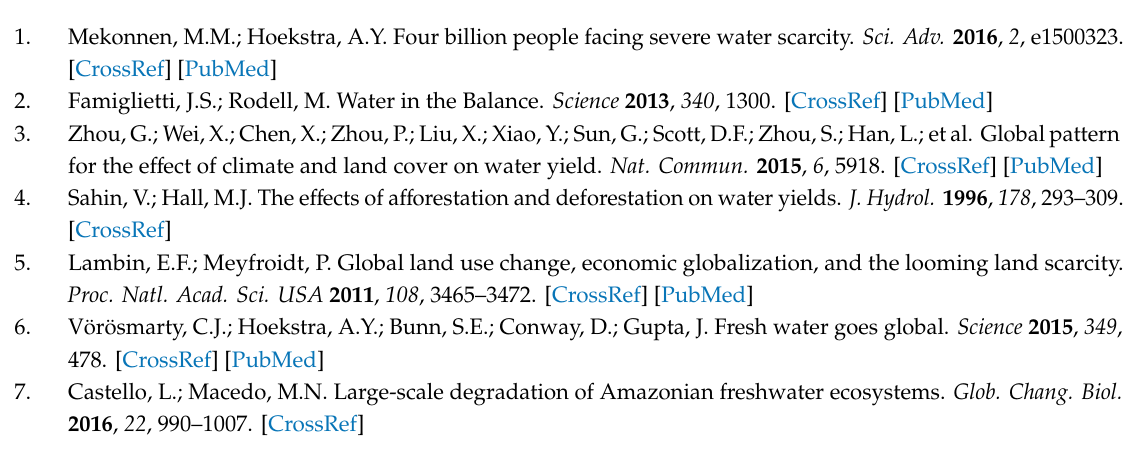
Figure S1: The variations of mean precipitation in wet (June to October) and dry seasons (November to May) based on precipitation record per month from the local weather bureau in Sanya City, China, Text S1: Methods for functional trait